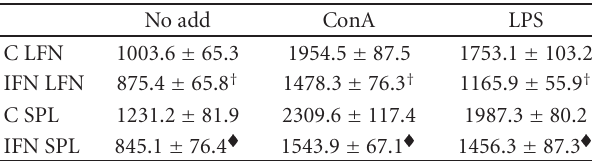
Table 1: Proliferation of splenocytes and mesenteric lymphocytes cultured in the presence or absence of IFN α .